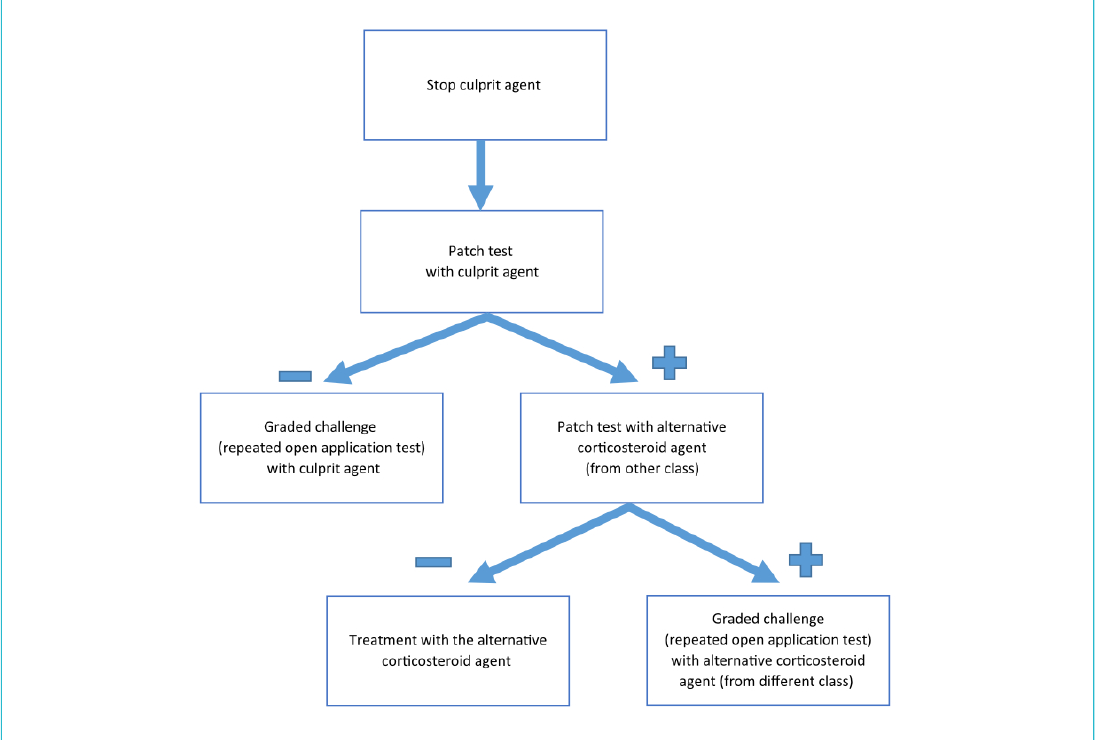
Figure 5: Procedure in the case of clinical suspicion of delayed hypersensitivity reaction to a